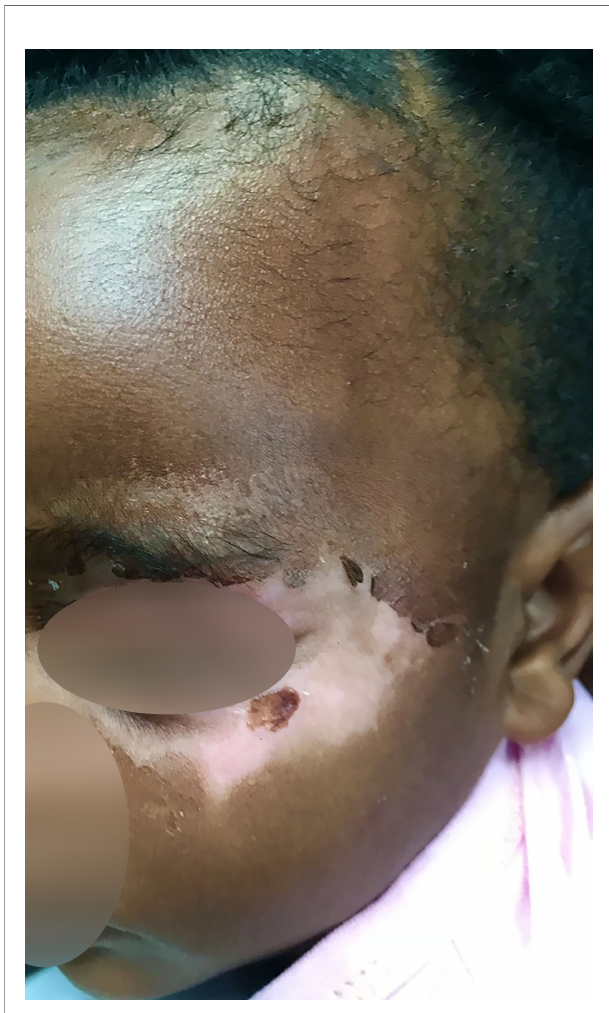
FIGURE 4 | Figure shows skin changes and alopecia in a child with detectable SSc speci fi c